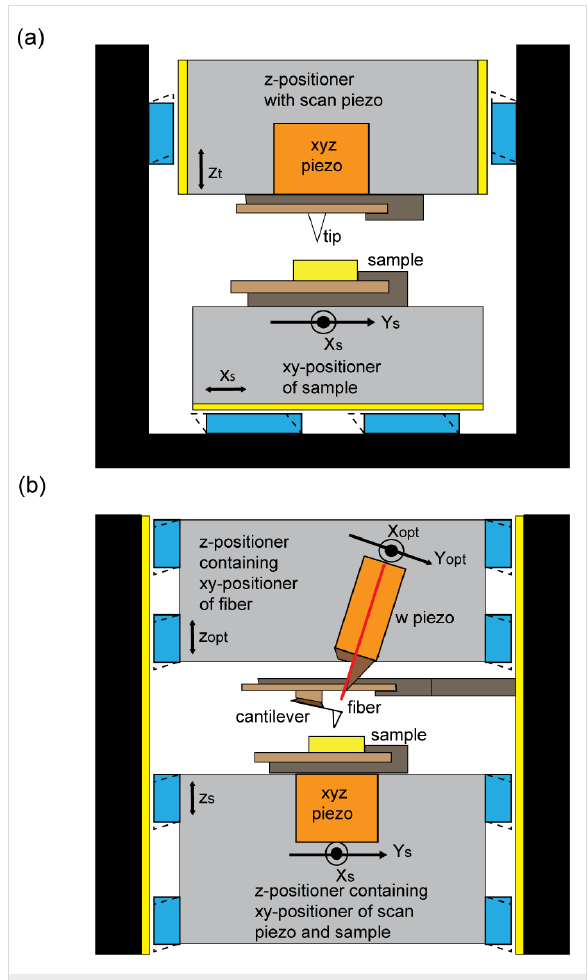
Figure 3: Schematics of the components of (a) a typical, classical STM/tuning fork-based AFM setup with the tip being scanned and (b) our AFM with the sample being